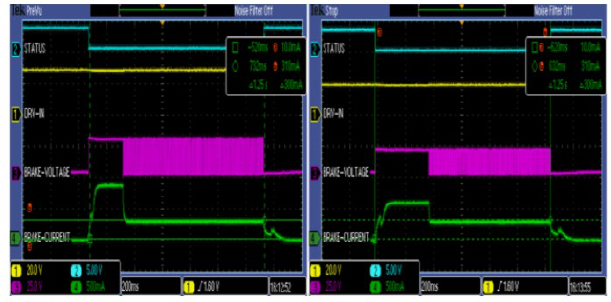
Figure 6. Hold current of Brake fixed to 300mA at 19-V and 28-V Input Voltage